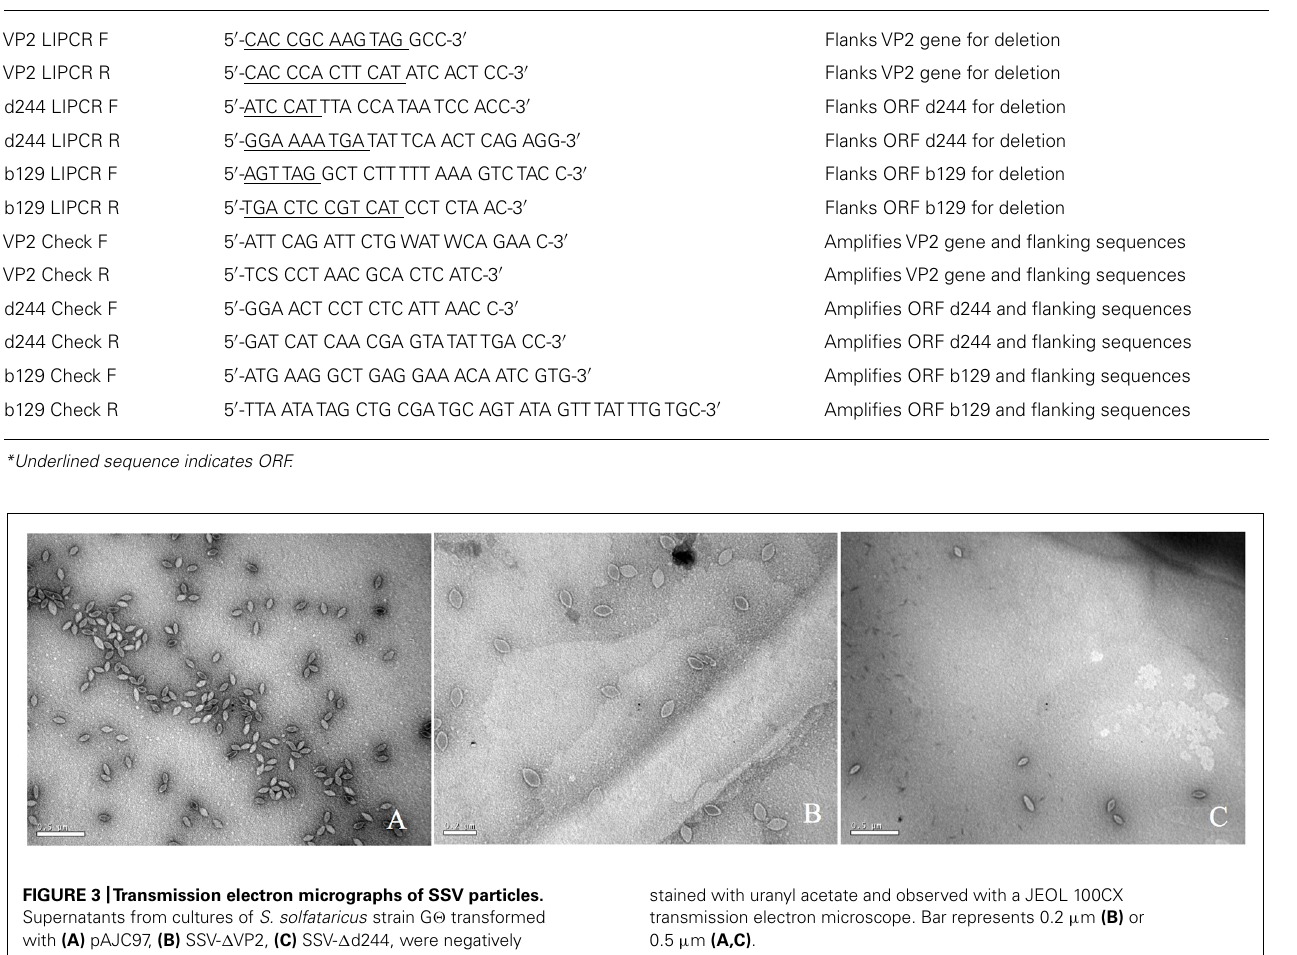
FIGURE 3 |Transmission electron micrographs of SSV particles. Supernatants from cultures of S. solfataricus strain G (cid:3) transformed with (A) pAJC97, (B) SSV- (cid:2) VP2, (C) SSV- (cid:2) d244, were negatively